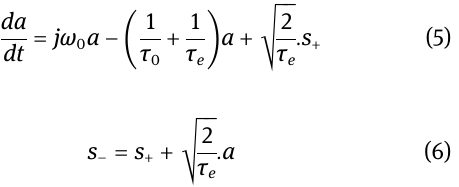
down by external stimuli, the effective capacitance and inductance are varied due to the change in the air gap and projected length of cantilever, forming variable parts of the LC circuit.